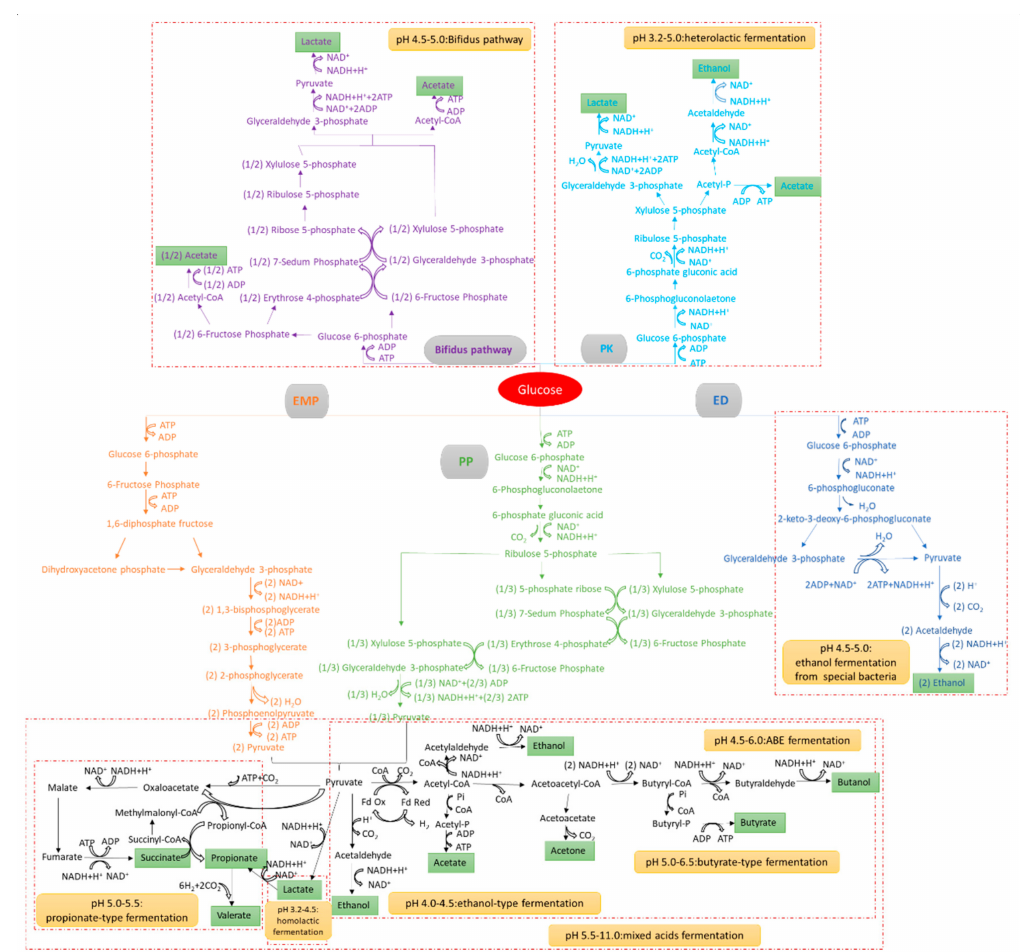
Figure 2. Metabolic pathways of glucose fermentation with mixed inoculation at di ff erent